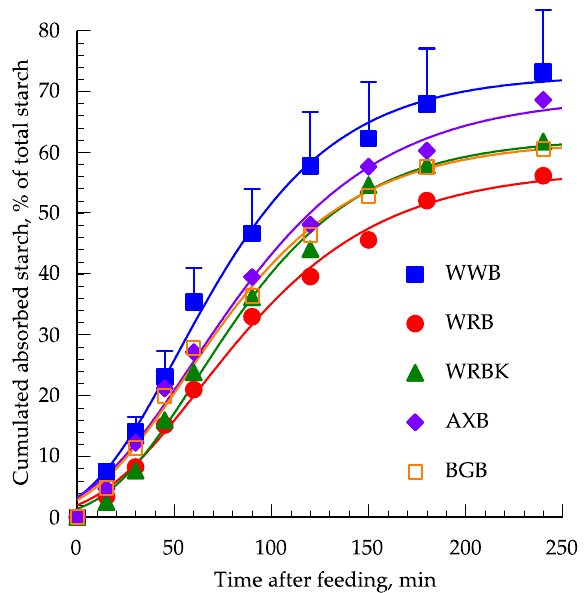
Figure 4. In vivo cumulative portal glucose appearance (% starch absorbed of ingested starch) of white wheat bread (WWB), whole grain rye bread (WRB), whole grain rye bread with kernels (WRBK), arabinoxylan bread (AXB) and beta-glucan bread (BGB). Values are the means ± SEM (n = 6). The k values in vitro varied from 0.0744 to 0.1595% hydrolysis/min with significant differences between WWB and BGB (Table 2). The k values in vivo showed no significant difference between breads but there was a trend for a higher k value for WWB than the other breads. The correlation between the in vitro and in vivo k values in this study was r = 0,78 ( p = 0.122) and when the data were combined with the data from the previous study of Vangsøe et al. [17] the correlation between the k values was r = 0.71 ( p < 0.05) (Figure 5).